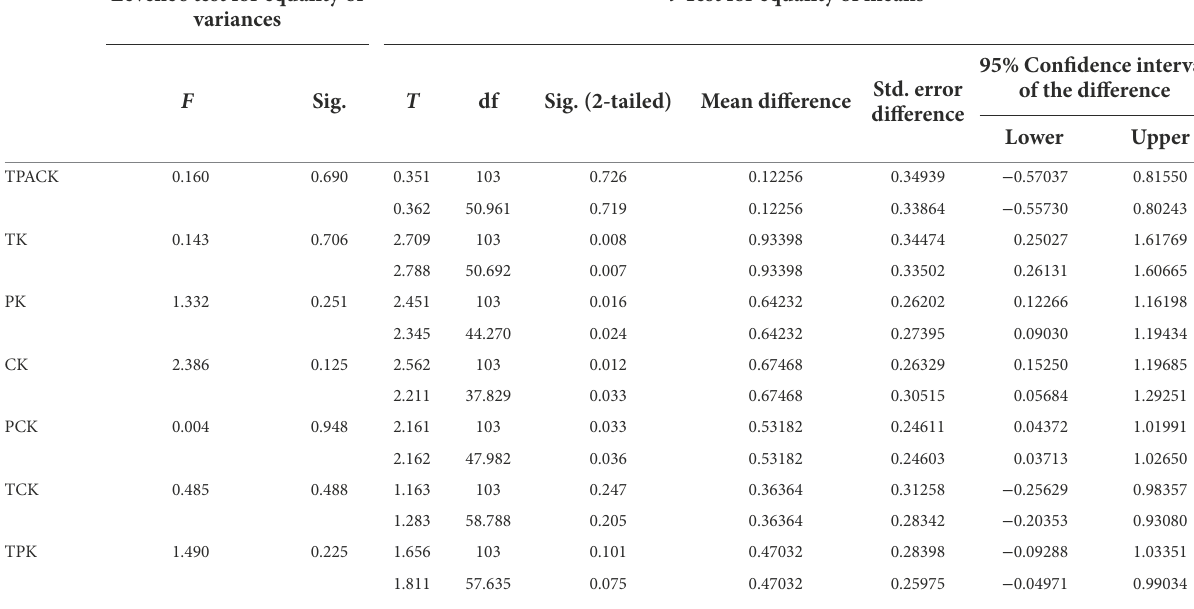
t -Test for equality of